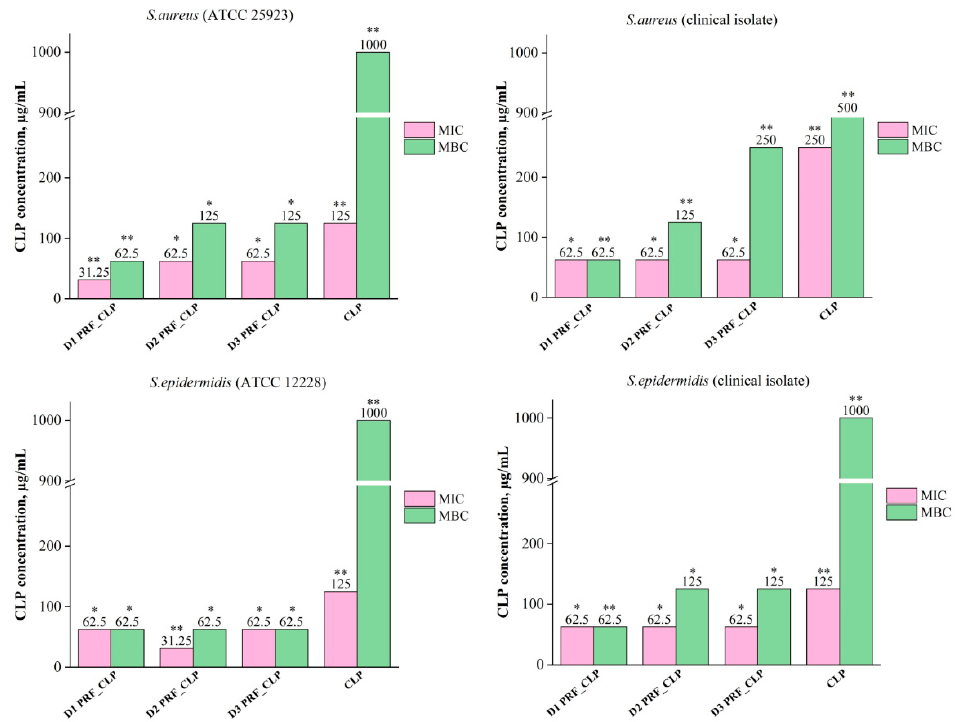
Figure 6. MIC and MBC value differences between CLP and PRF_CLP samples against four bacteria stains ( S. aureus (ATCC 25923), S. epidermidis (ATCC 12228), S. aureus (clinical isolate) and S. epidermidis (clinical isolate) for all three donors. Samples prepared from donor 1 blood (D1 PRF_CLP); samples prepared from donor 2 (D2 PRF_CLP); samples prepared from donor 3 (D3 PRF_CLP). * p > 0.05; ** p <0.05.